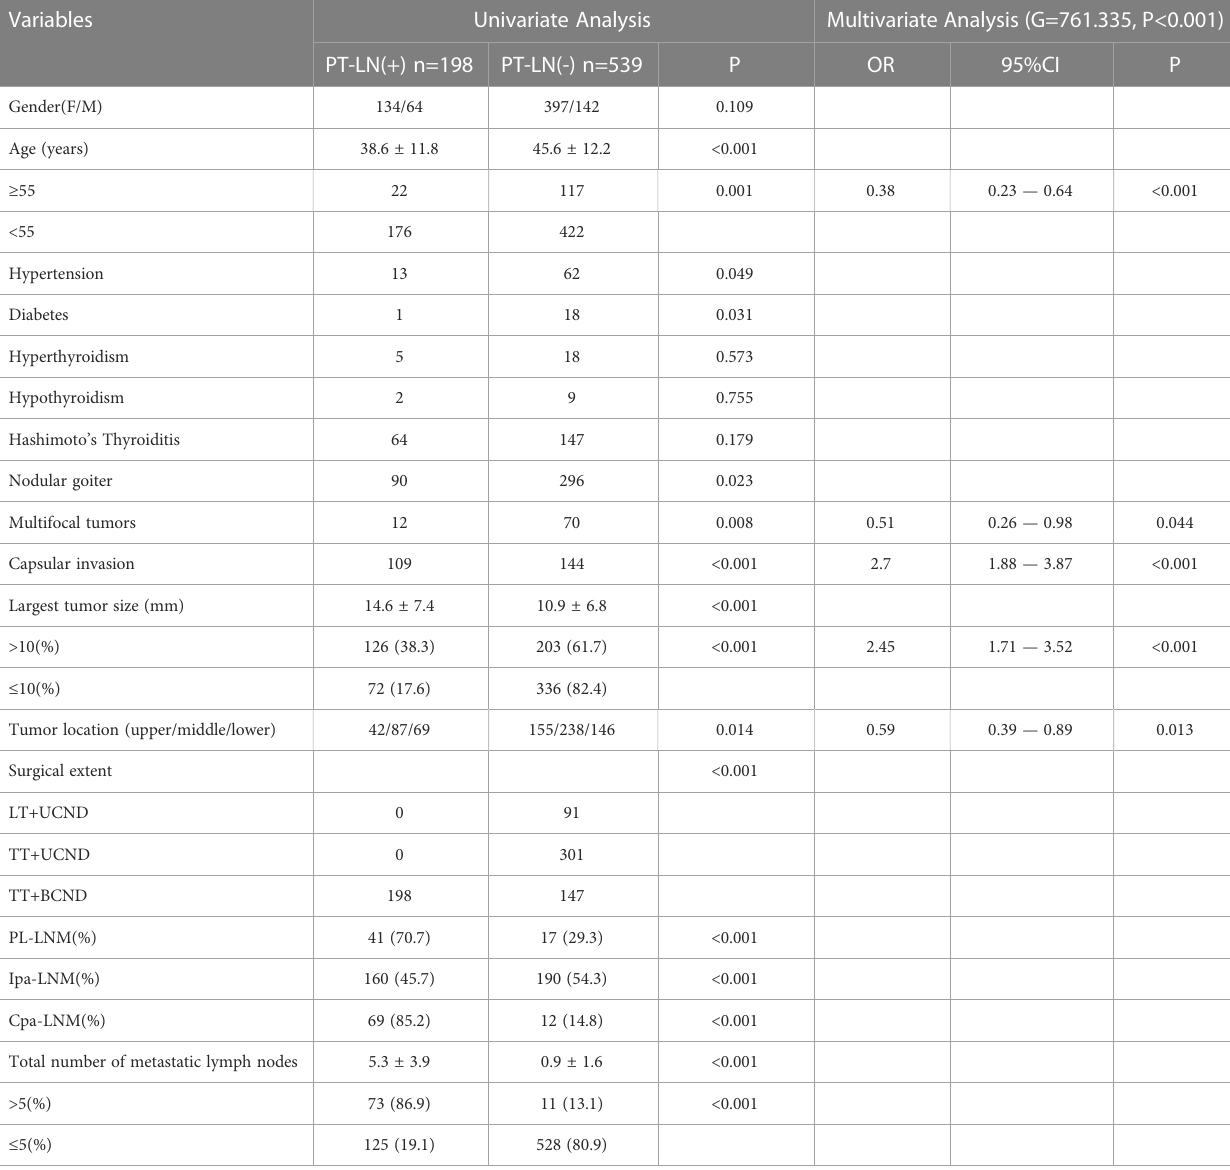
TABLE 1 The risk factors for pretracheal lymph node metastasis.